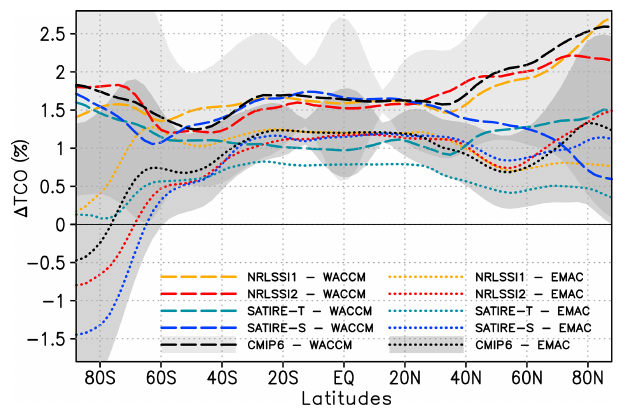
Figure 9. Annual mean zonally averaged 11-year solar cycle re- sponse in total column ozone (TCO) in percent for WACCM (long dashed) and EMAC (dotted) for prescribed SSI data sets NRLSSI1(CMIP5) (yellow), NRLSSI2 (red), SATIRE-S (blue), SATIRE-T (light blue), and CMIP6 (black). The 95% uncertainty range is given for simulations with the CMIP6 data set for WACCM (light grey shaded) and EMAC (dark grey shaded).